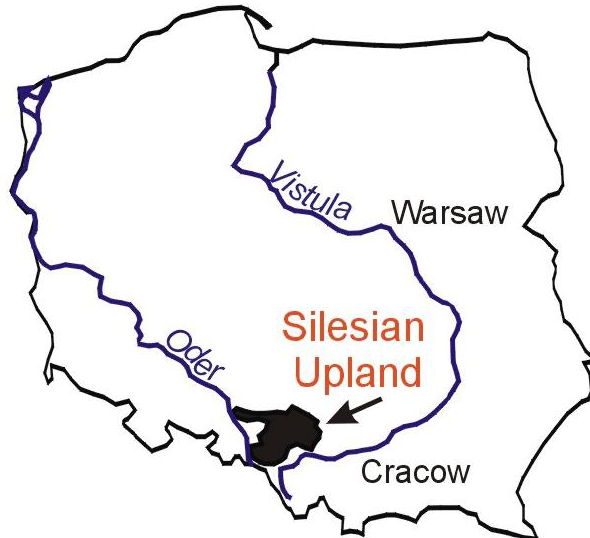
Fig. 1. Location of the study area